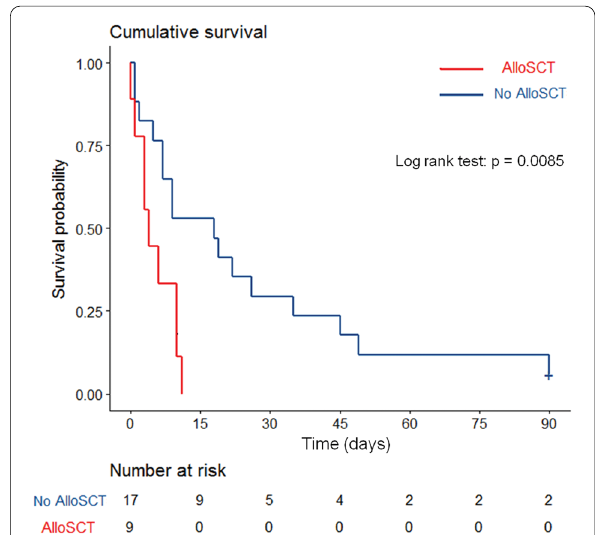
Fig. 2 Kaplan–Meier curve reporting unadjusted influence of allogeneic stem cell transplantation (alloSCT). Kaplan–Meier curve estimates of overall survival in allogeneic stem cell transplant recipients ( n 9, red) and in other hematological patients ( n = blue). Survival between groups was compared using the Kaplan– Meier estimator. Univariate analysis was performed with the log rank